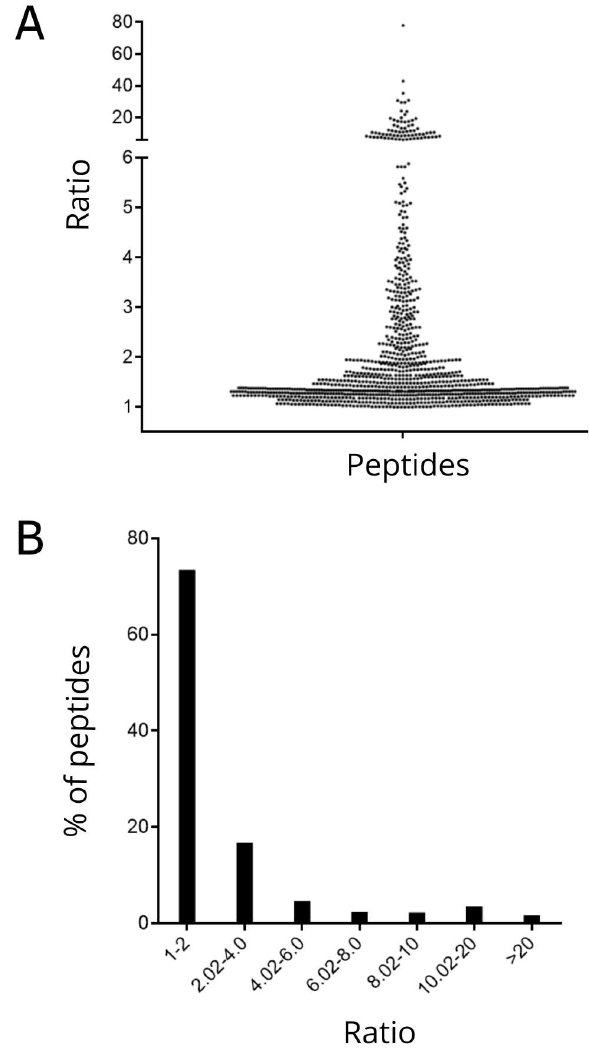
Figure 3. Average ratio of each peptide found in H. reidi gills ( A ). Percentage of peptides in different ranges of ratio ( B